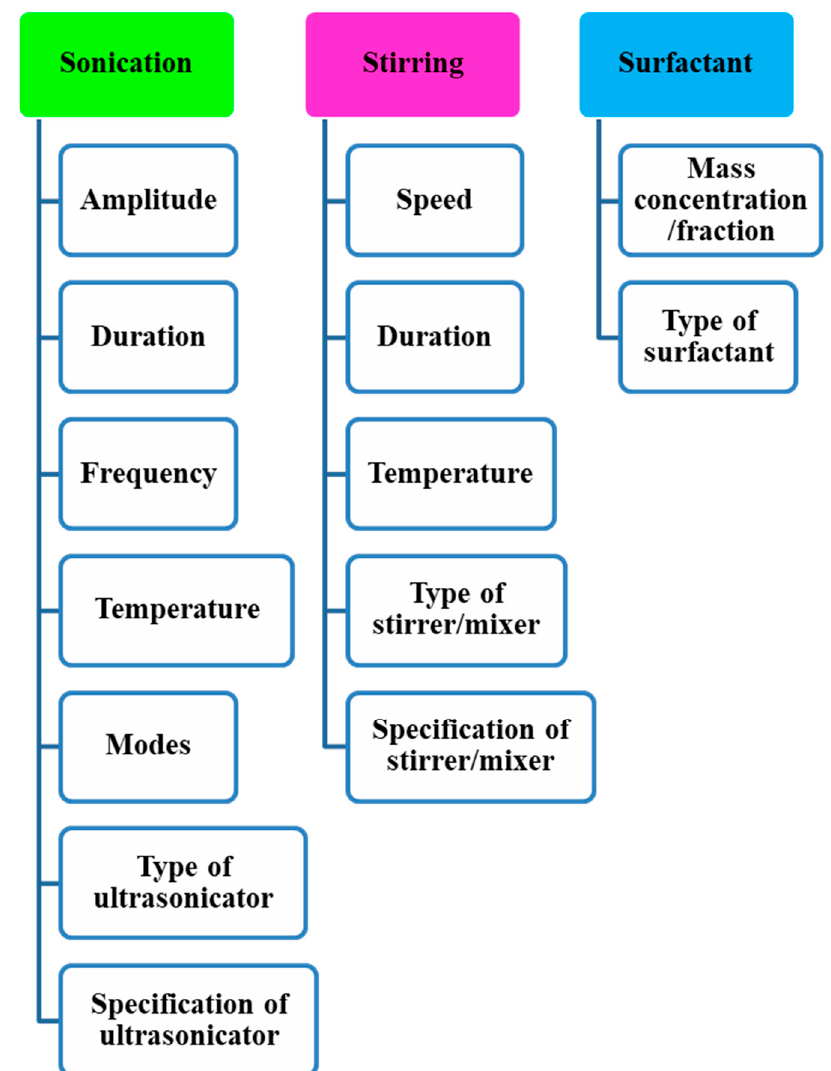
Figure 15. Parameters for nanofluid preparation for different preparation approaches.